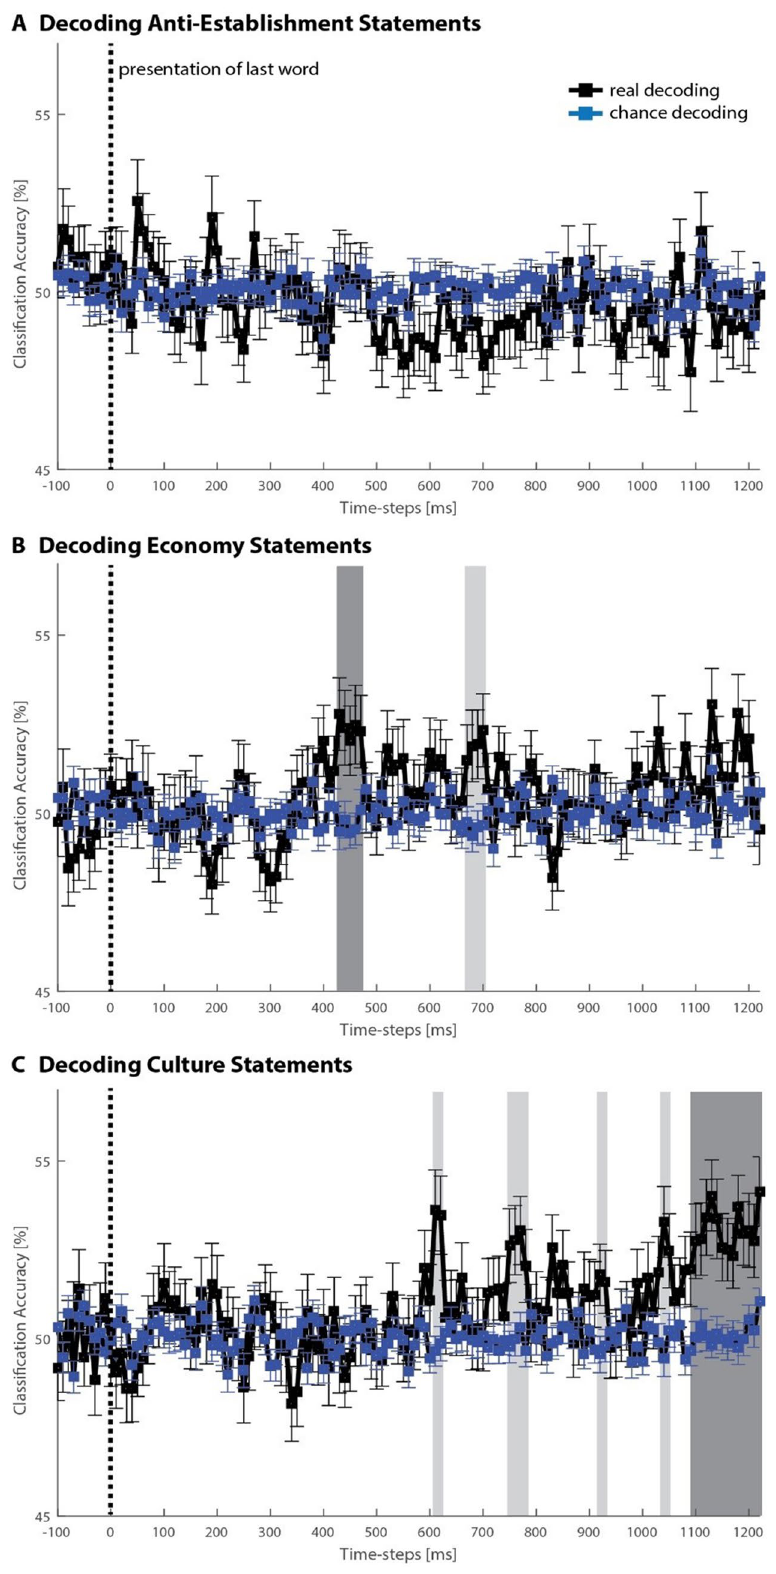
Figure 3. Multivariate pattern classification. EEG data results (N = 67) for the decoding of populist vs. non-populist items for the three political issue dimensions: ( A ) Anti-establishment, ( B ) economy, ( C ) culture. Significant classification indicates that neural patterns in small analysis windows of 10 ms allowed for the prediction of whether an item on a given trial expressed populist or non-populist views. Dark grey bars indicate significant clusters (minimum two time windows) after correction for multiple comparisons; light grey bars indicate significant clusters uncorrected (p <